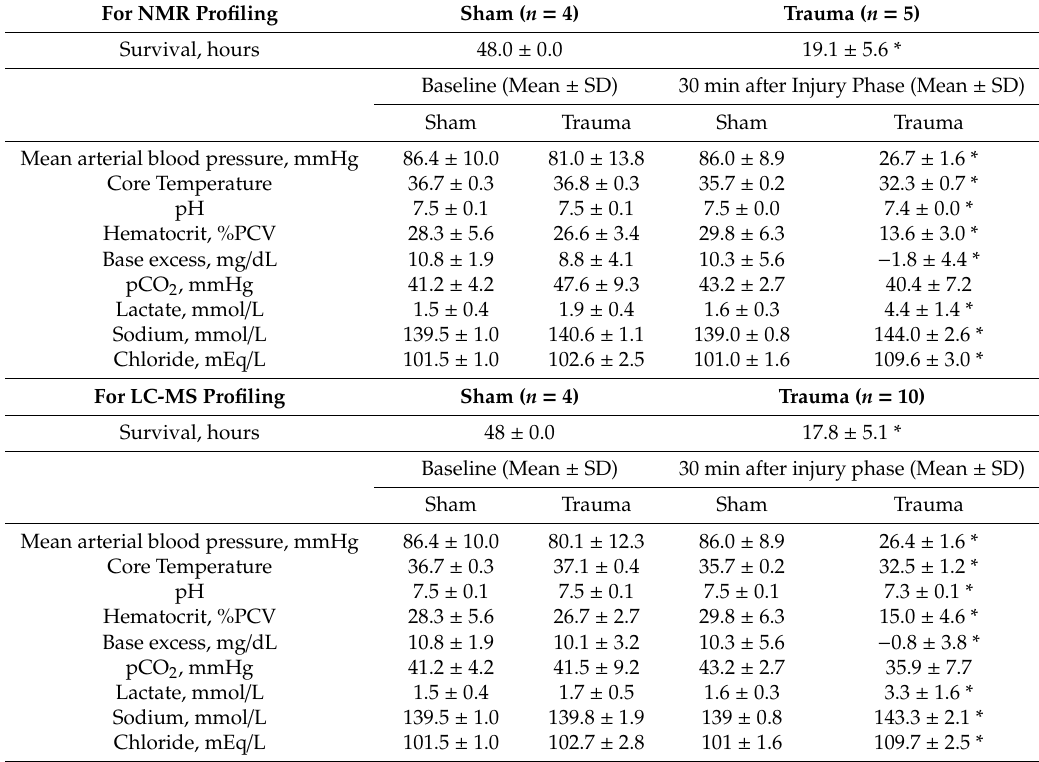
Table 1. Survival, physiological parameters, and blood chemistry of sham and traumatized